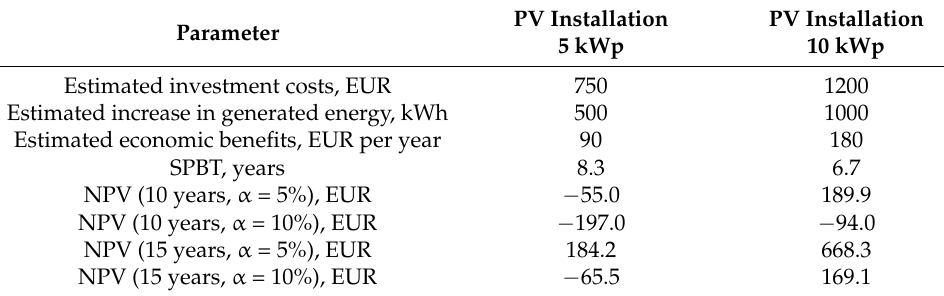
Table 3. Economic aspects of introducing the colling